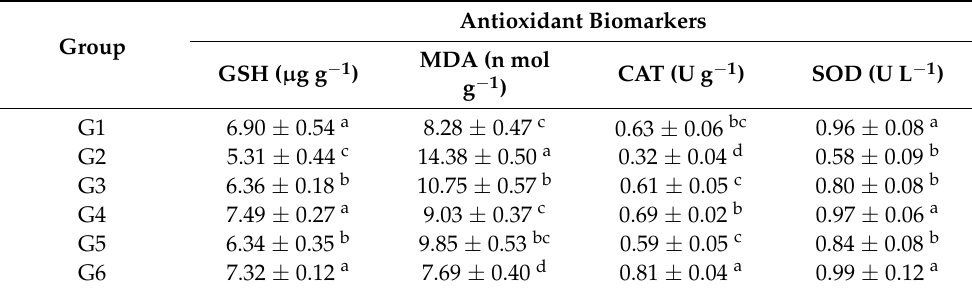
Table 8. The effects of FS and FSS extracts on antioxidant biomarkers in kidney tissue of CCl 4 -induced nephrotoxicity and oxidative stress in rats (mean ± SE), n = 4.